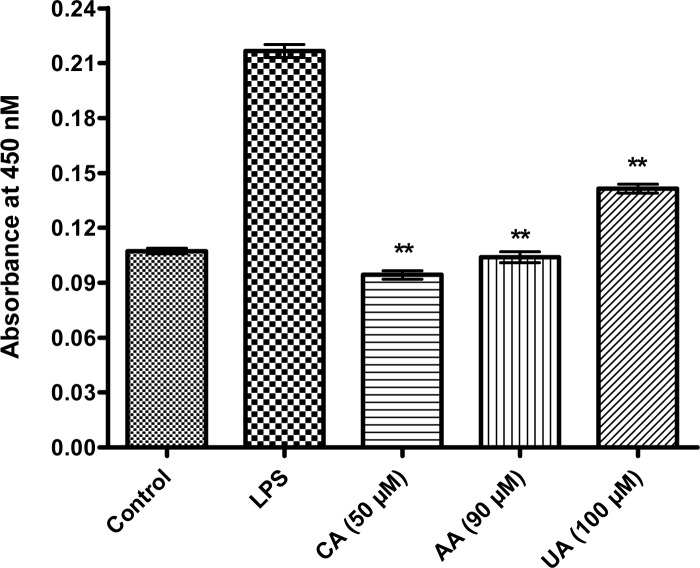
CA, AA and UA inhibited IFN-γ release from LPS stimulated RAW cells.
In vitro (supernatant) level of IFN-γ in LPS stimulated RAW cells treated with CA, AA and UA detected through indirect ELISA. Y axis represents the absorbance at 450 nm. Data represented as mean ± SD of three independent experiments. **P < 0.01 (ANOVA) as compared with LPS treated group.